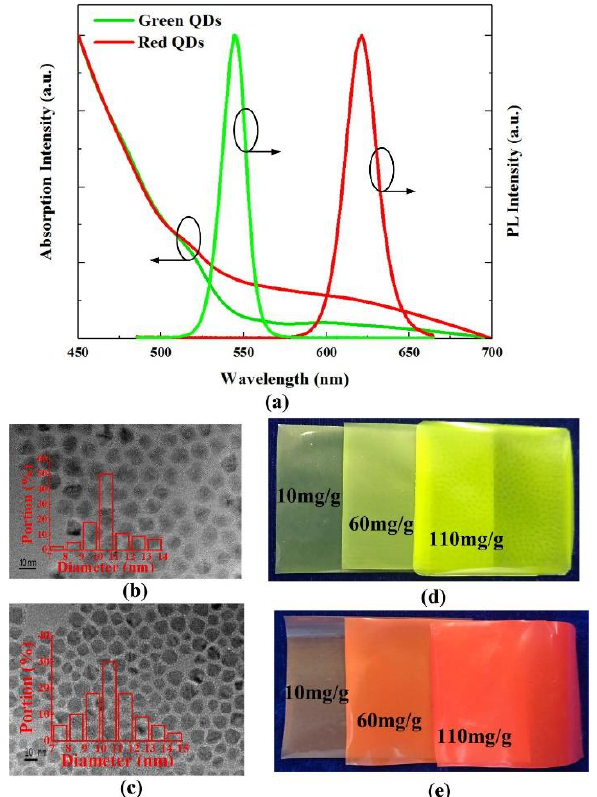
Figure 2. ( a ) Absorption and PL spectra of the green / red QDs; ( b ) and ( c ) TEM images of the as-prepared green and red QDs, respectively; and ( d ) and ( e ) photographs of the green and red QDs-PMMA film, respectively.